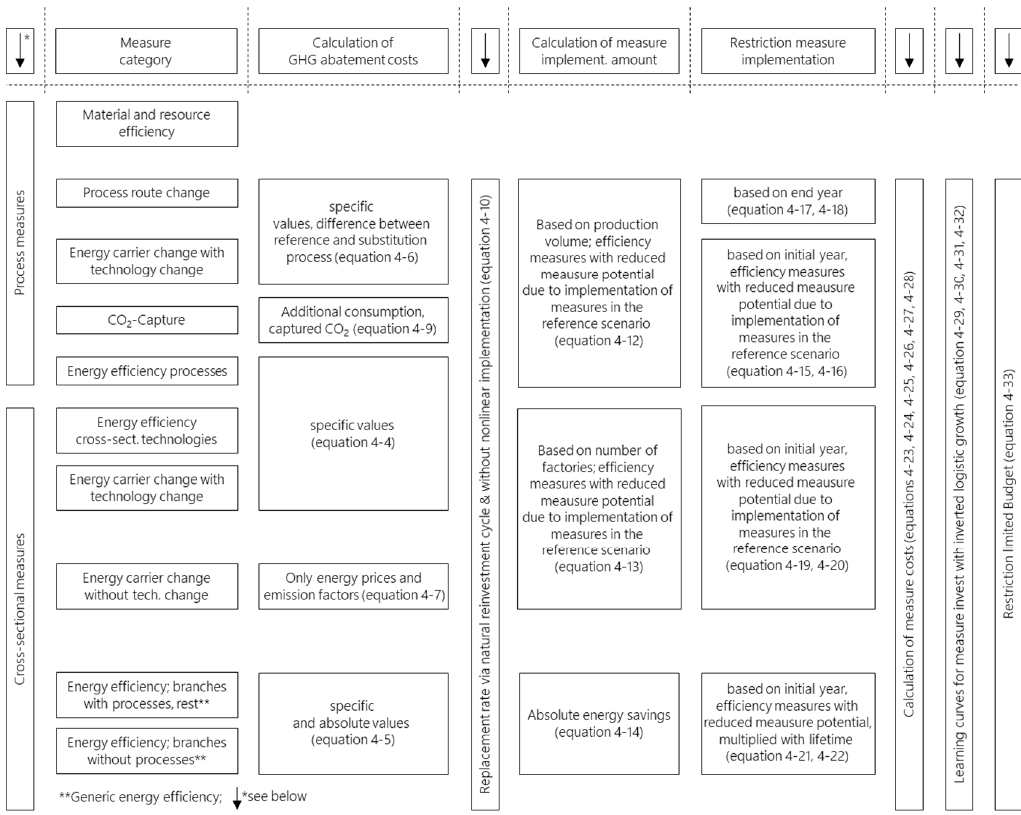
Figure 5. Assignment of equations according to measure categories to implement GHG abatement measures in TMI.